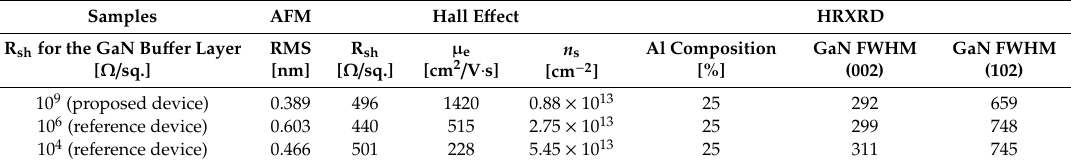
Table 1. Structural and electrical properties in Al x Ga x − 1 N/GaN high-electron-mobility transistors (HEMTs) with different GaN buffer resistance measured by atomic force microscopy (AFM), Hall effect, and high-resolution X-ray diffraction (HRXRD).